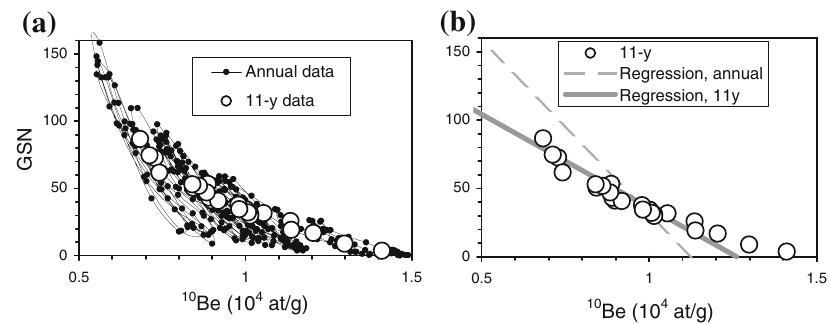
Fig. 14 Scatter plot of smoothed group sunspot numbers versus (2-year delayed) 10 Be concentration. a Annual (connected small dots ) and 11-year averaged ( big open dots ) values. b Best-fit linear regressions between the annual ( dashed line ) and 11-year averaged values ( solid line ). The dots are the same as in panel ( a ). (After Usoskin and Kovaltsov